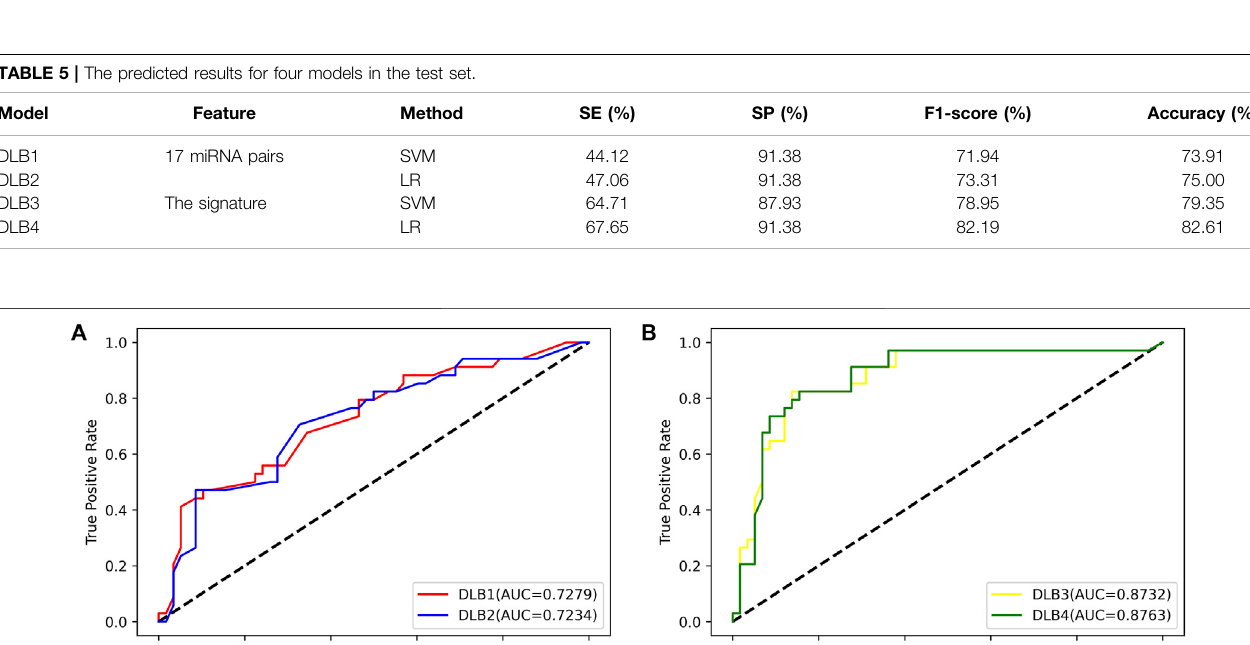
Frontiers in Genetics |